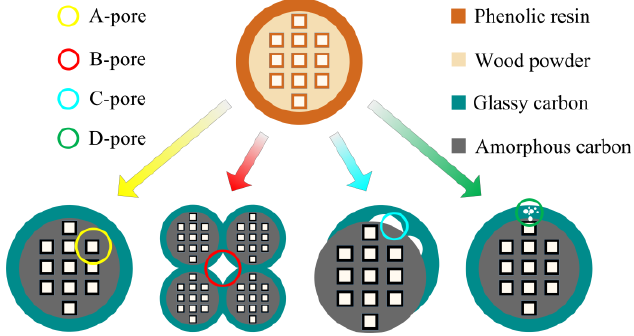
Figure 6. Schematic diagram of the pore formation principle of C WCMs.